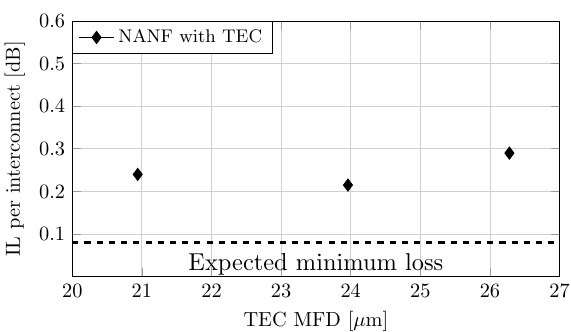
Figure 6. Insertion loss of SMF-28-NANF interconnect using TEC-based MFAs of various